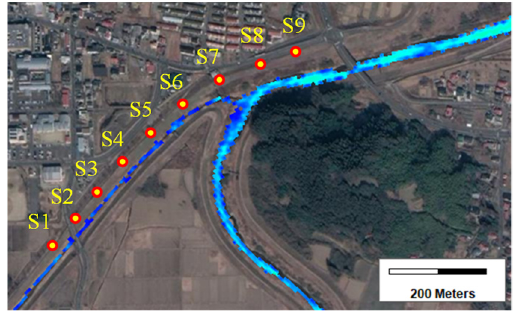
Figure 21. Extracted points on the left riverbank of the Shin River.